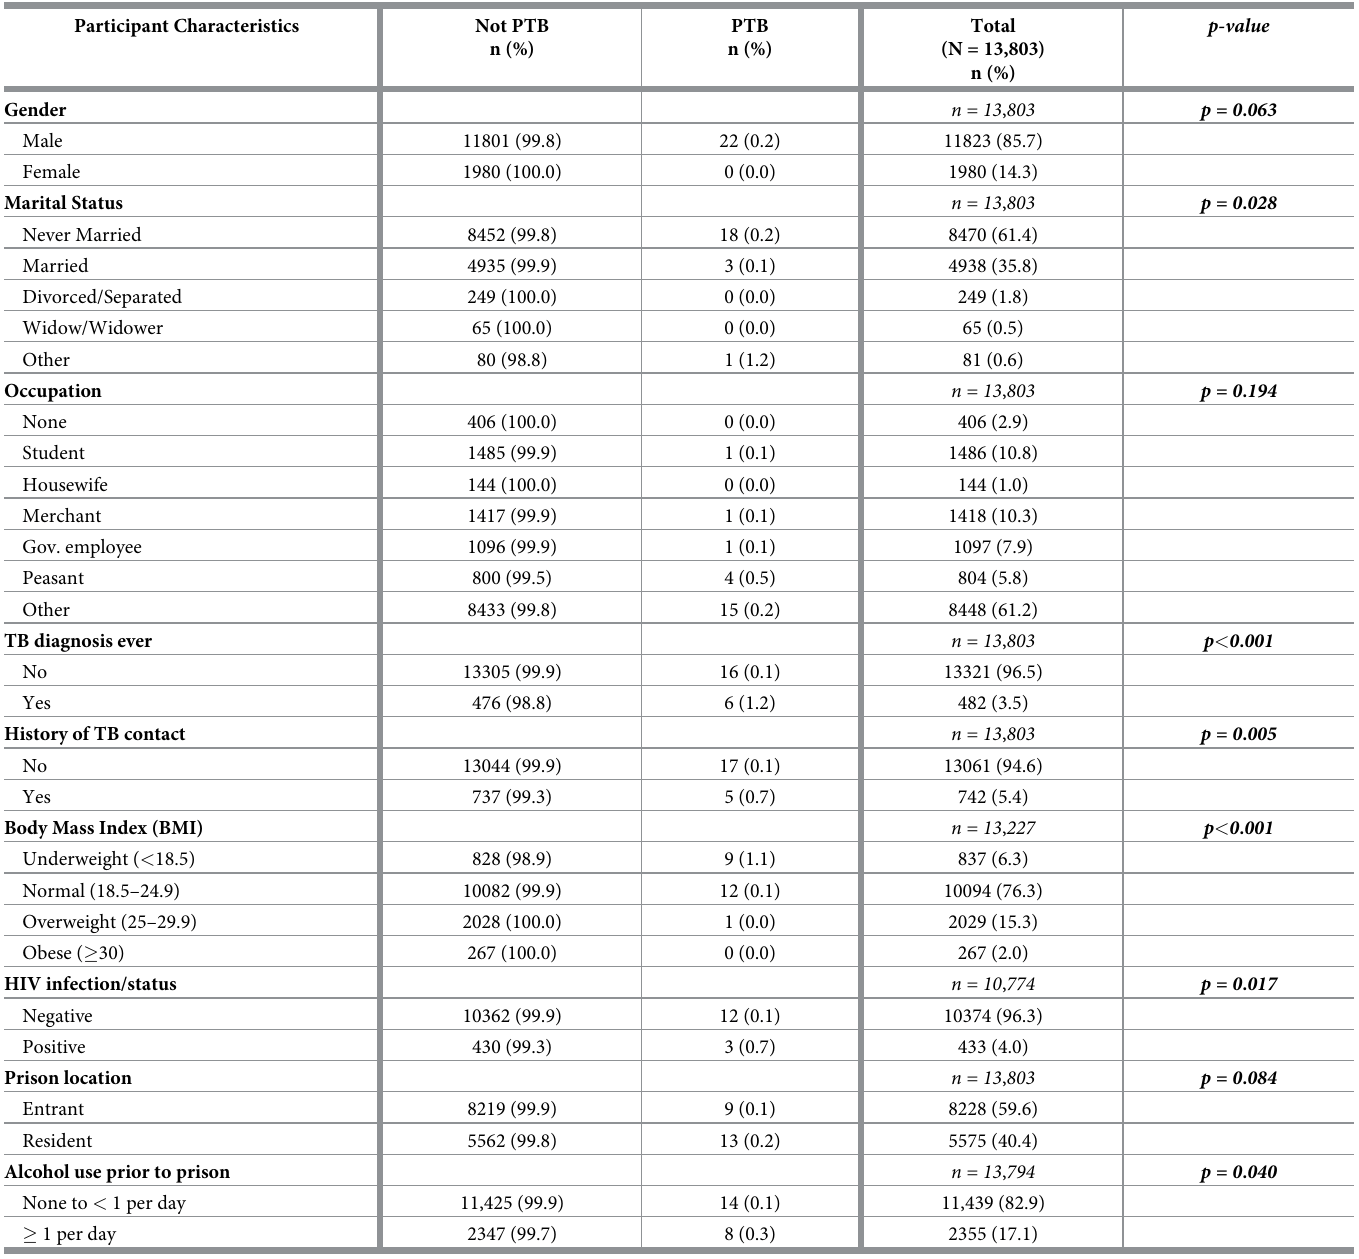
Table 5. Bivariate analysis of BC-PTB and risk